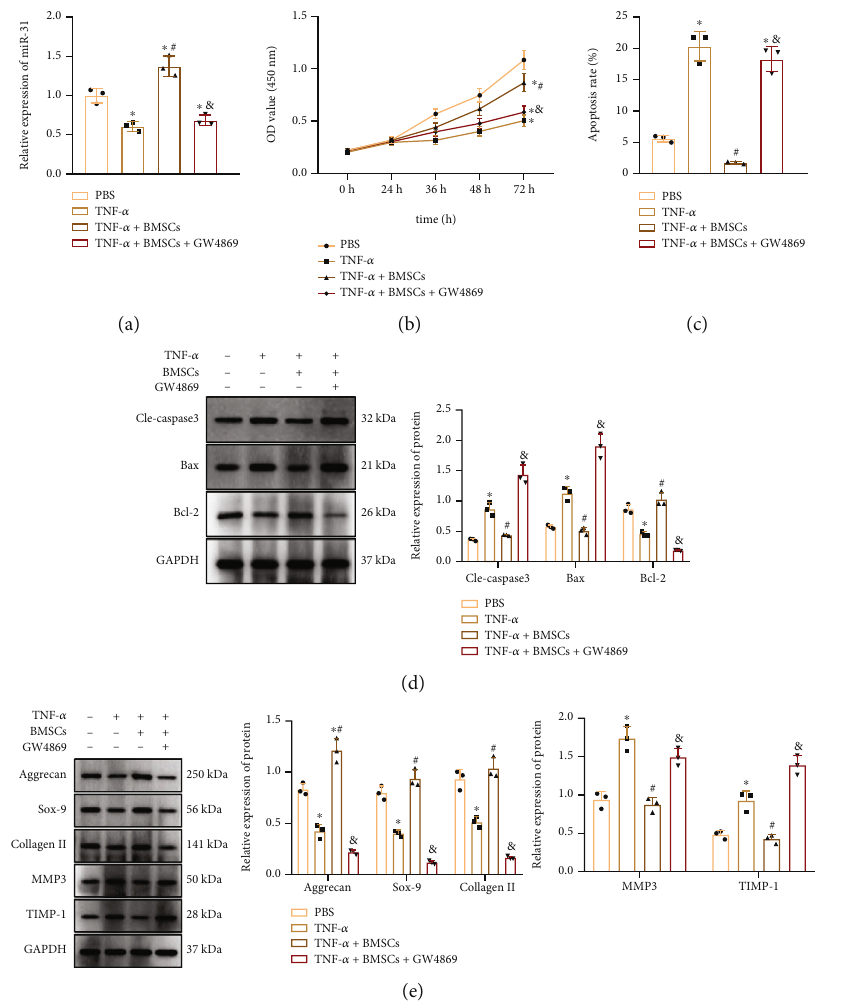
Figure 4: hBMSC-EVs inhibit NPC apoptosis and ECM degradation and promote cell proliferation in NPCs. (a) miR-31 expression in TNF- α -treated NPCs cocultured with BMSCs or further treated with GW4869 determined by qRT-PCR. (b) Proliferation of TNF- α - treated NPCs cocultured with BMSCs or further treated with GW4869 determined by CCK-8 assay. (c) Apoptosis of TNF- α -treated NPCs cocultured with BMSCs or further treated with GW4869 determined by fl ow cytometry. (d) Protein expression of apoptosis- related genes cleaved caspase-3, Bax, and Bcl-2 in TNF- α -treated NPCs cocultured with BMSCs or further treated with GW4869 determined by Western blot. (e) Protein expression of ECM-related genes in TNF- α -treated NPCs cocultured with BMSCs or further treated with GW4869 determined by Western blot. ∗ p < 0 : 05 vs. PBS; # p < 0 : 05 vs. TNF- α ; & p < 0 : 05 vs. TNF- α +hBMSCs. Cell experiments were repeated three